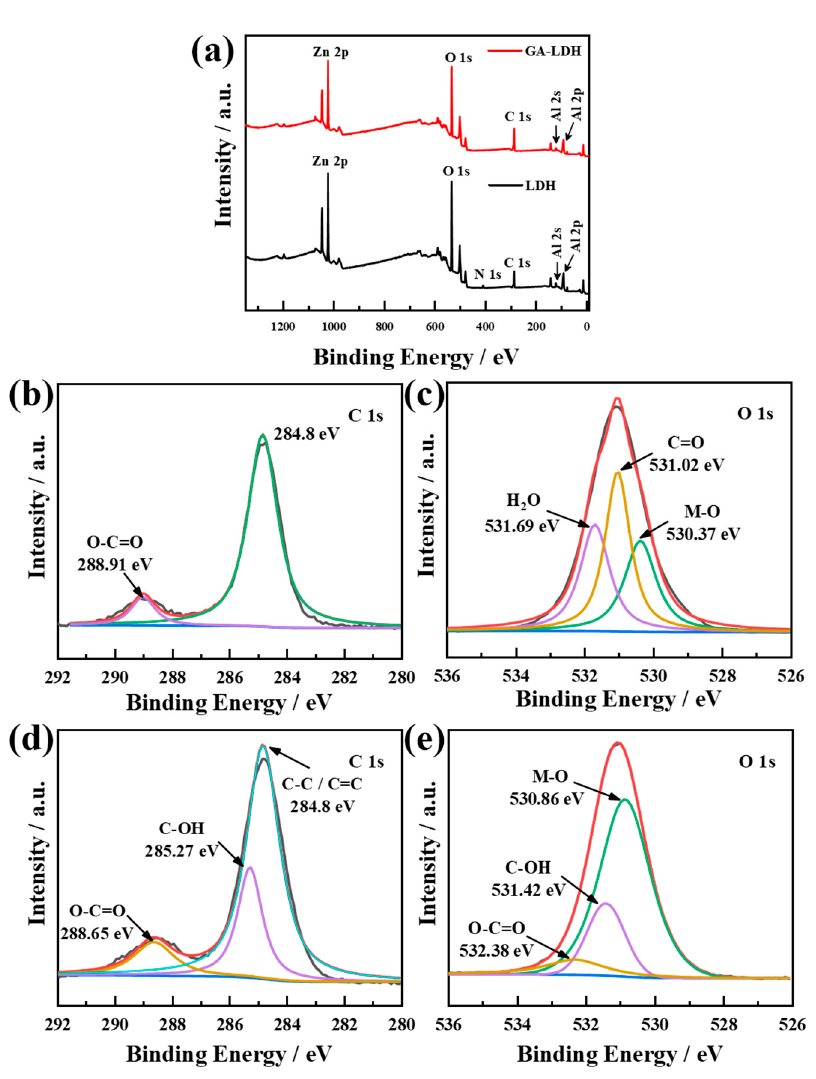
Figure 6. XPS spectra of ( a ) LDH and GA-LDH. High-resolution XPS spectra of LDH ( b ) C 1s, ( c ) O 1s and GA-LDH ( d ) C 1s, ( e ) O 1s.